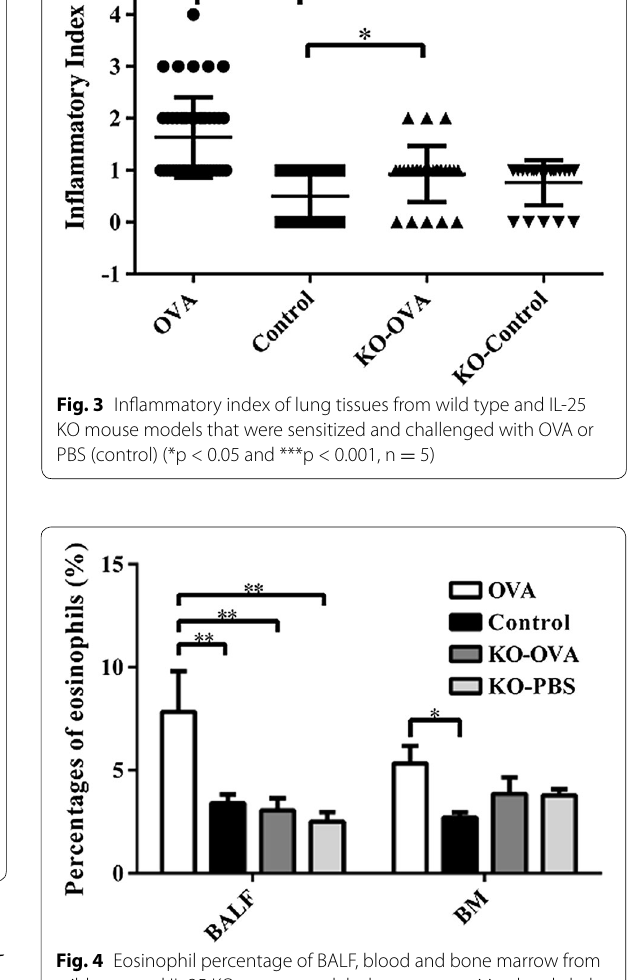
Fig. 4 Eosinophil percentage of BALF, blood and bone marrow from wild type and IL-25 KO mouse models that were sensitized and chal- lenged with OVA or PBS (control) (*p < 0.05 and **p < 0.01, n